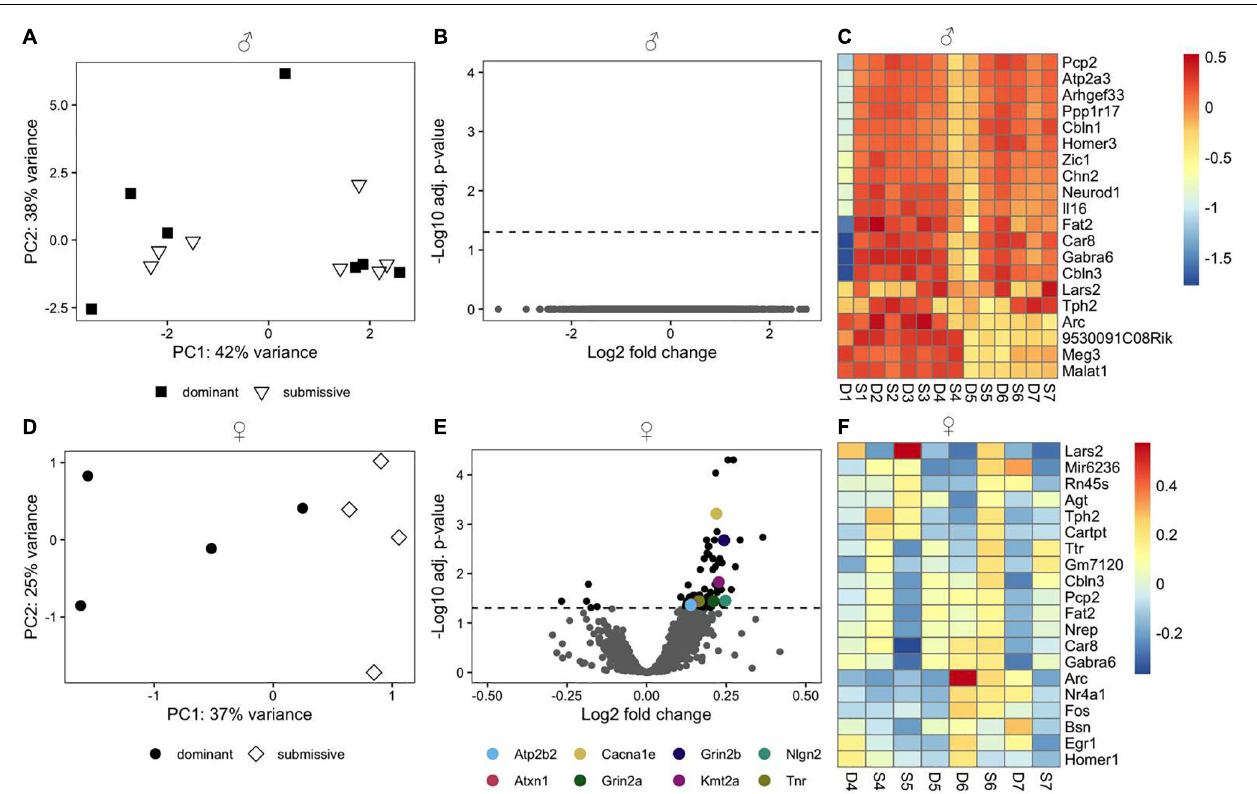
FIGURE 3 | Transcriptomic profile of brain samples from male and female mice according to social rank. Differences in the multivariate expression pattern in brain hemispheres of male (A) and female (D) dominant and submissive mice were visualized with PCA using the top 500 most variable genes. Volcano plots display differentially expressed genes (adjusted p < 0.05, shown as black dots, n = 7 for males and 4 for females) in male (B) or female (E) mice. Positive log2 fold changes indicate genes that are up-regulated in dominant mice, while negative log2 fold changes correspond to down-regulated genes. The horizontal dashed line on the volcano plots labels the threshold for differentially expressed genes (adjusted p < 0.05). The 20 genes with the highest variance across samples were determined for male (C) and female (F) animals and visualized with a heatmap using rlog transformed counts. Counts were centered around the respective mean value for each